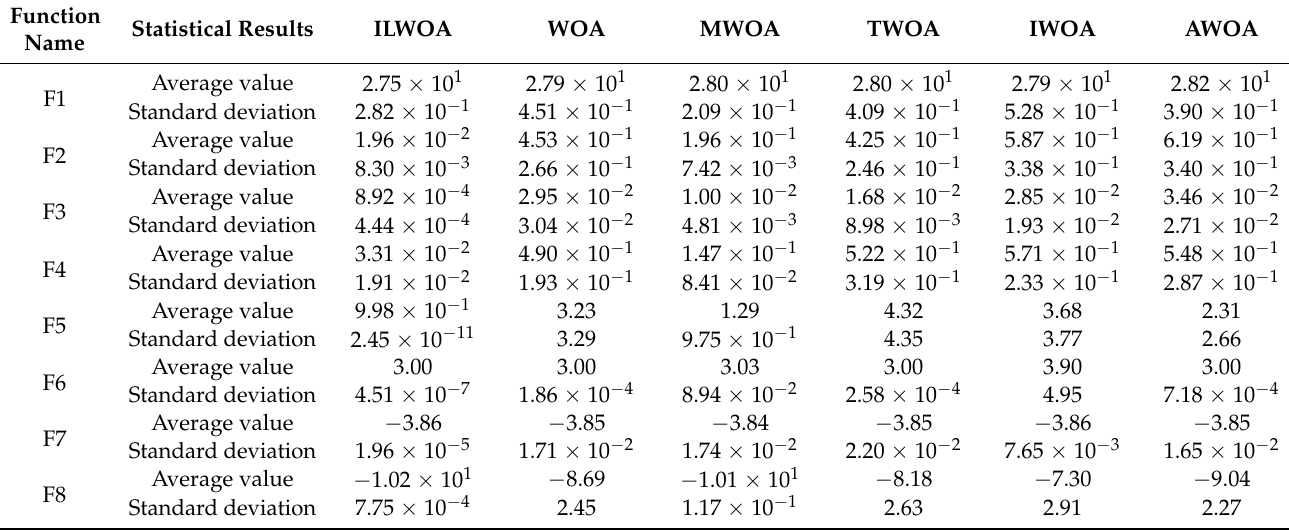
Table 3. Experimental results of standard test